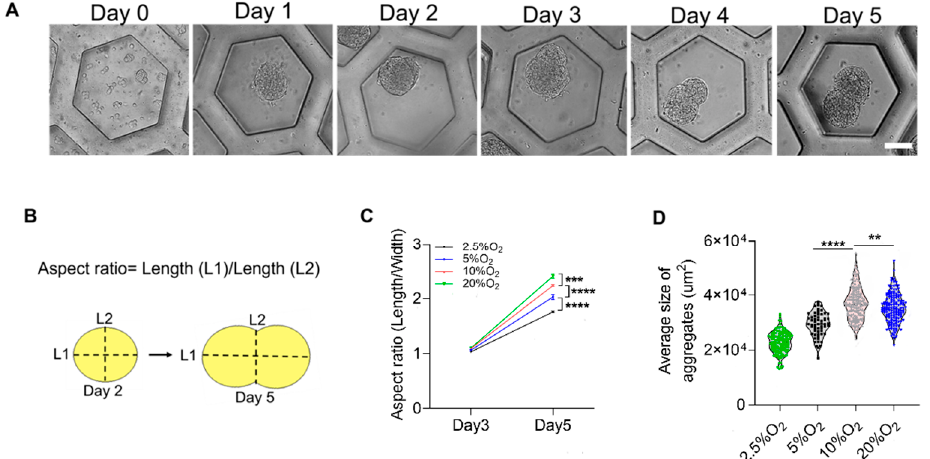
Figure 2. Formation and characterization of the aggregates. ( A ) Aggregates forming through 5 days of culture in honeycomb-shaped microwells, scale bar: 50 µm. ( B ) Schematic illustration of measur- ing the aspect ratio and comparing Days 2 and 5. ( C ) Aspect ratio of the aggregates at Days 2 and 5. ( D ) The average size of the aggregates versus oxygen. Statistical analysis was performed with one- way ANOVA/Tukey’s test. ** p < 0.01, *** p < 0.001, **** p < 0.0001; ns = non-significant with N = 3 sets of independent experiments.